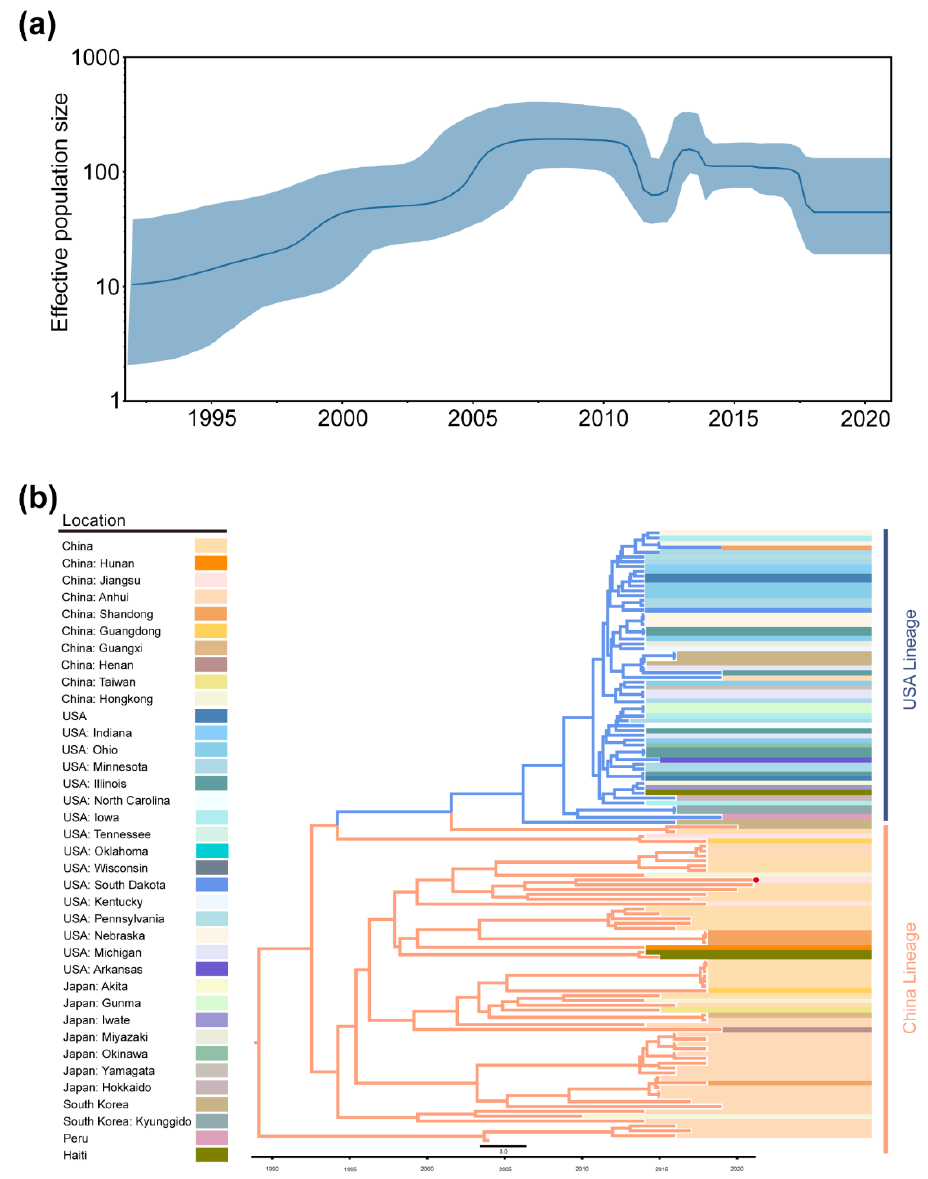
Figure 5. Demographic history of PDCoV. ( a ). Demographic history was inferred via Bayesian skyline analysis. The median and 95% HPD intervals were plotted. ( b ). MCC tree of PDCoV complete genome. Different colors represented different lineages (we merged early China lineage into China lineage). The red dot indicates that the strain was sequenced in this study.